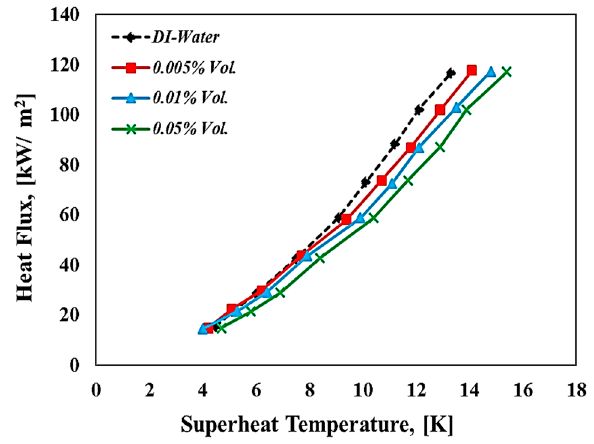
Figure 9. Boiling curves for water and WO 3 -based water nanofluids at di ff erent volume concentrations.